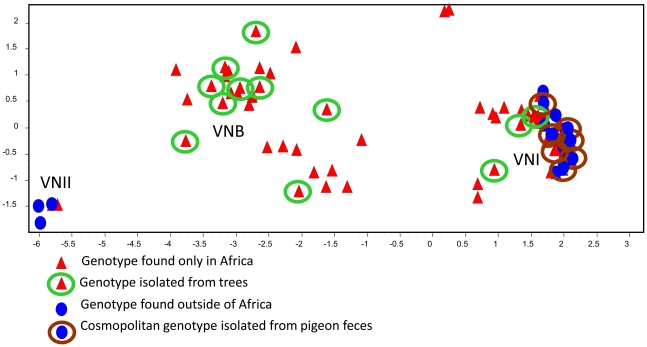
The genetic relationships among 72 MLST genotypes are visualized by Principal Component analysis (PCA).Each symbol represents a genotype with a unique eight-digit allelic profile (re Fig. 4). Red triangles represent genotypes of strains that are endemic to Africa, and blue circles represent genotypes of global strains. Genotypes associated with African trees are enclosed in green circles, and genotypes associated with pigeon excreta are enclosed in brown circles. Genotypes without circles represent clinical strains that to date have not been isolated from the environment.